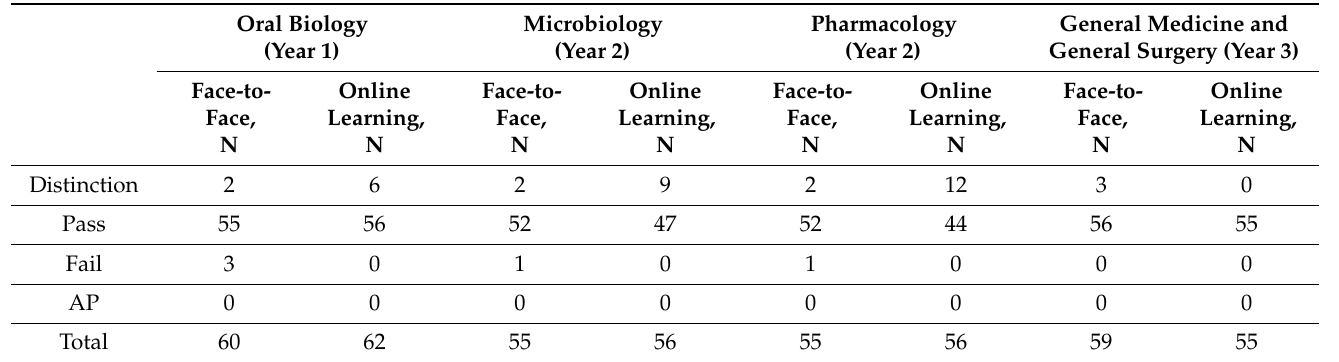
Table 4. Examination results for selected Year 1, 2, and 3 subjects, with a significant mean score improvement with online